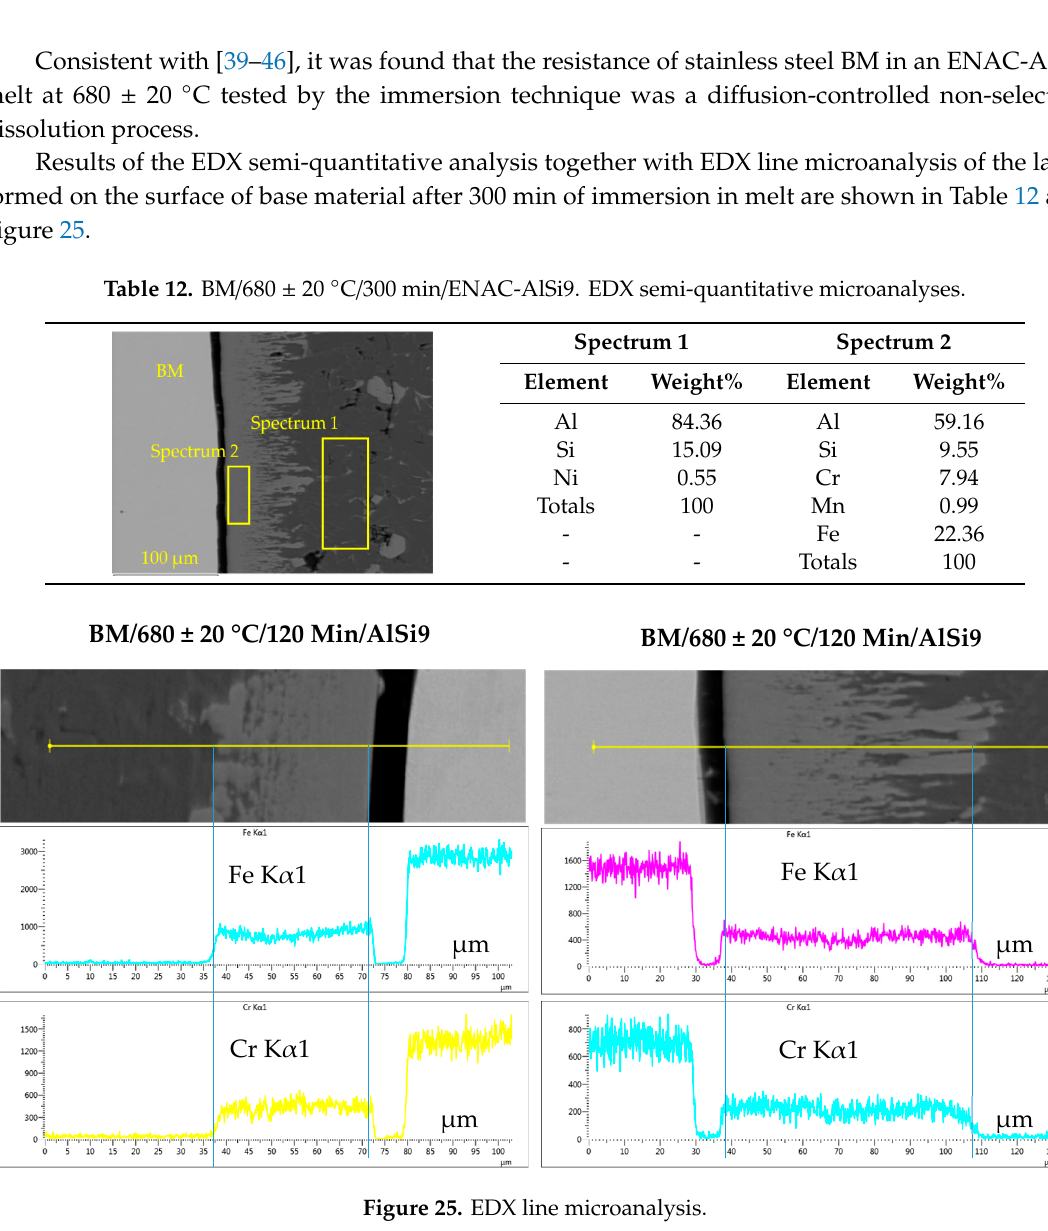
Figure 25. EDX line microanalysis.